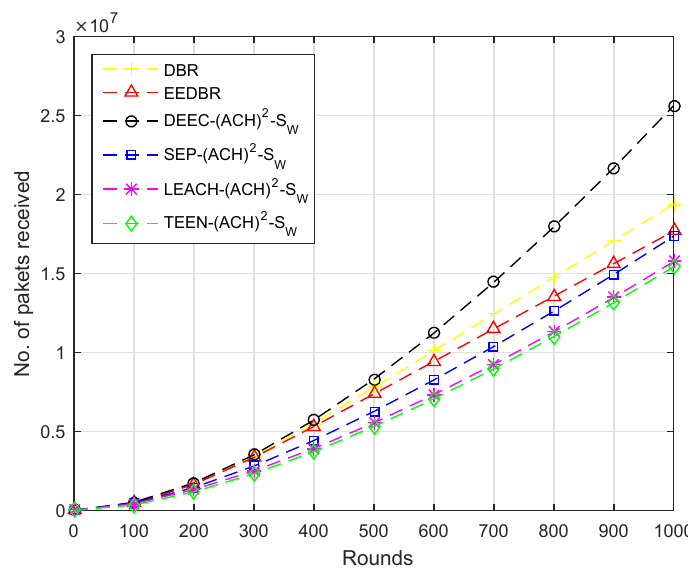
Figure 7. Number of Packets Received at